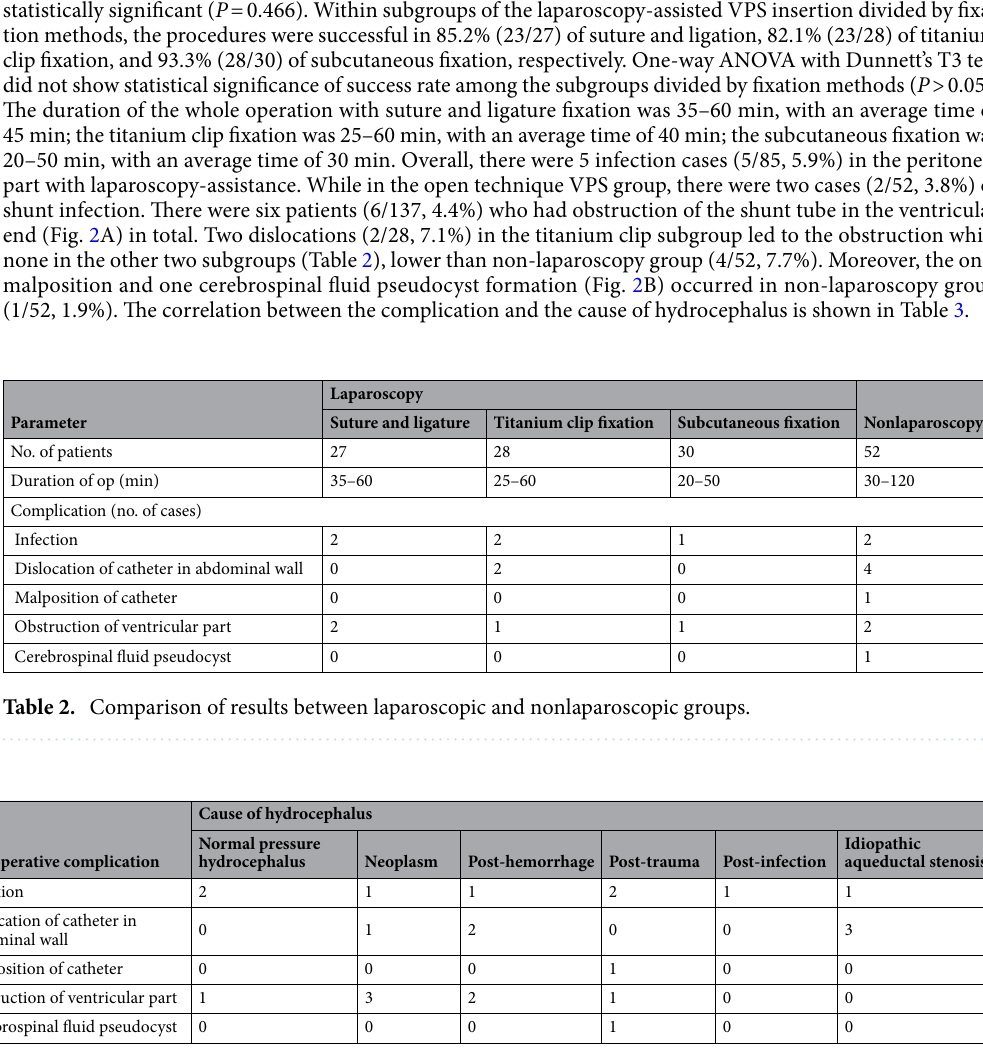
Table 3. Correlation between postoperative complications and causes of